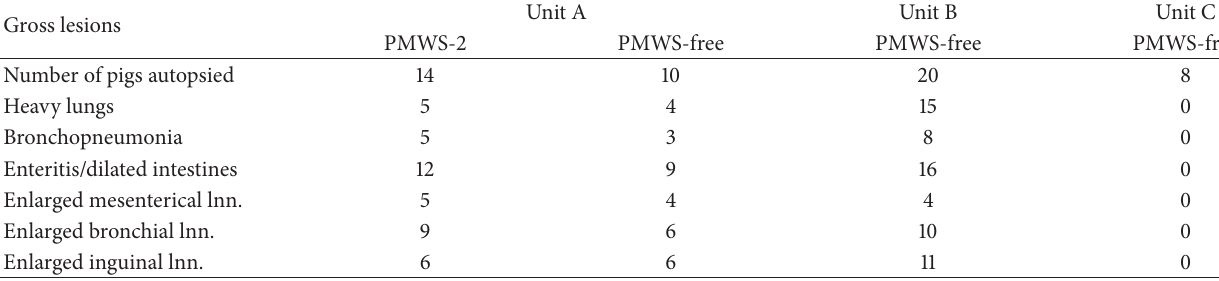
Table 2: Gross lesions detected on autopsied pigs from the four units in experiment 2.